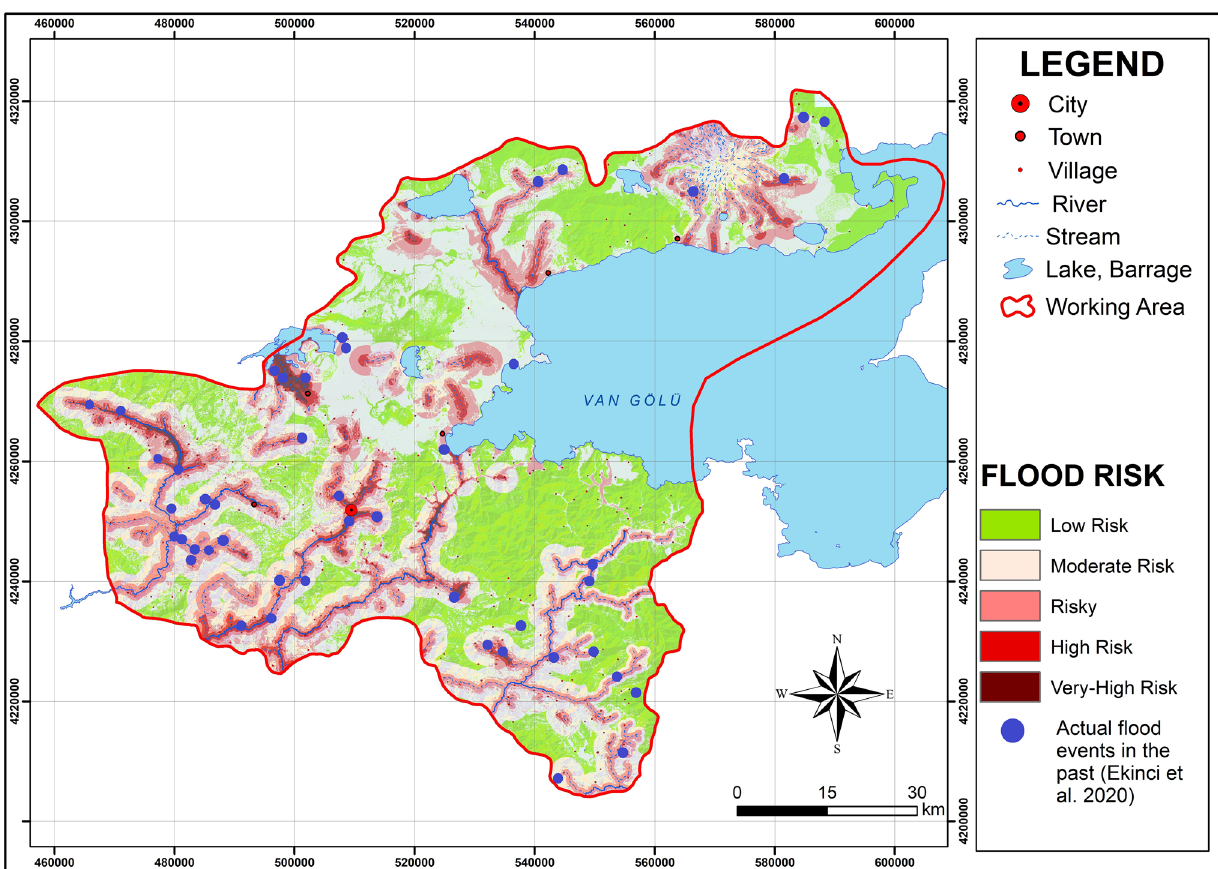
Fig. 5 Flood risk